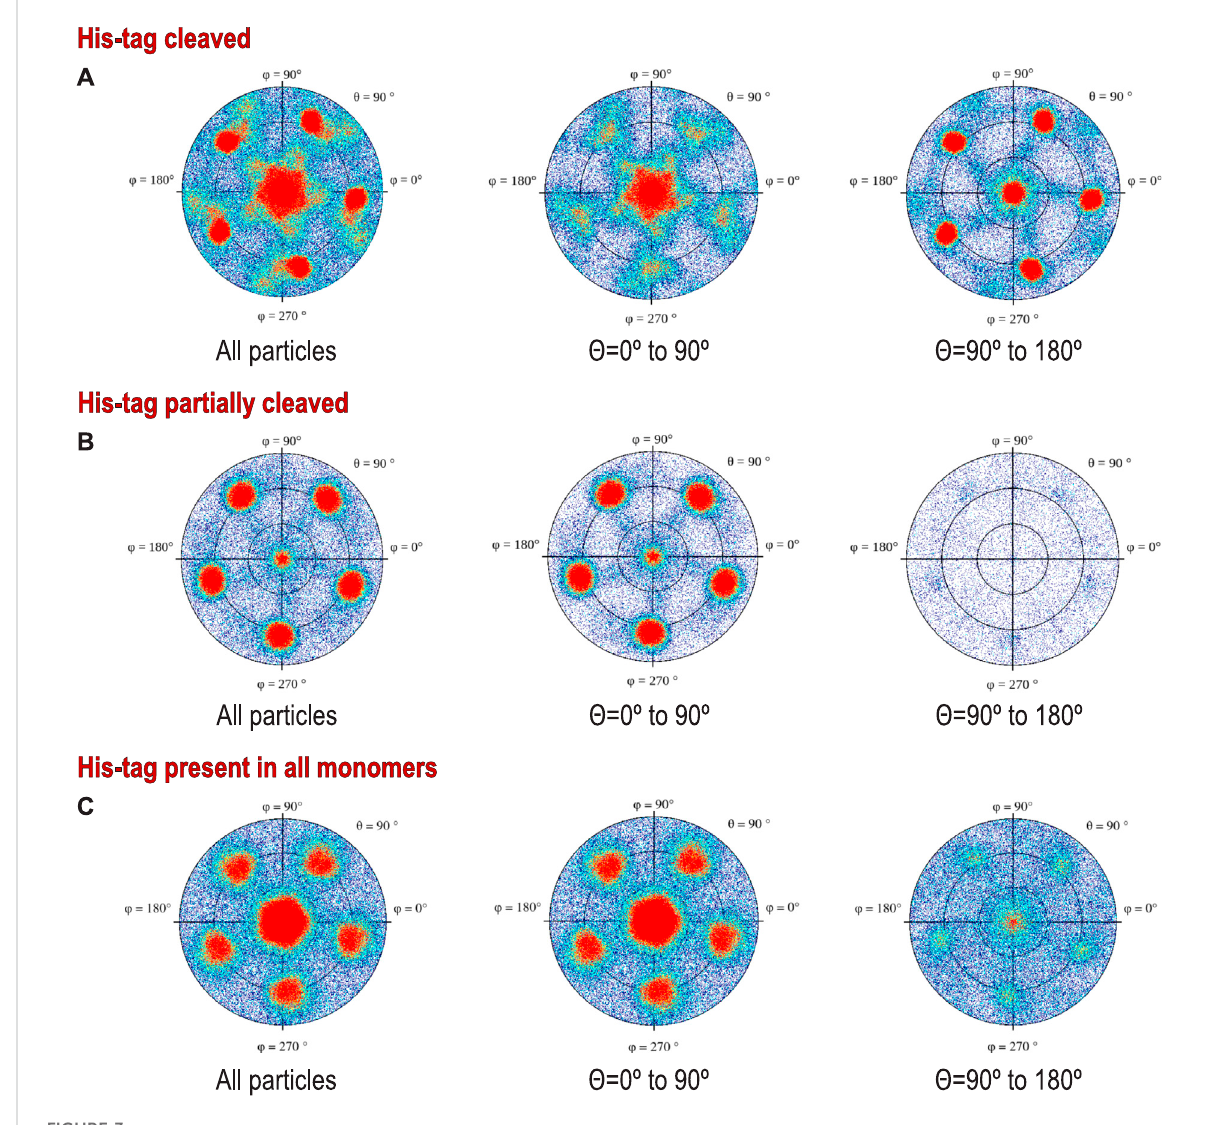
FIGURE 3 Preferred orientations (heat plots) shown in polar coordinates for protein with: (A) His-tag cleaved protein, (B) His-tag partially cleaved, and (C) His-tag uncleaved. To stress the difference in the polarity of the particles, we show on the left traditional plots for all particles, while the middle and right fi gures show (+) and (-) polarities (particles tilted away from or toward the beam). The different polarities result from different angles of interactions with the AWI, but also may result from interactions with two separate AWIs, which would symmetrize the histogram, as the cosine of the angle between the particle and the beam changes sign for the same geometric interaction with the AWI. We do not directly know how much these two effects contribute to our